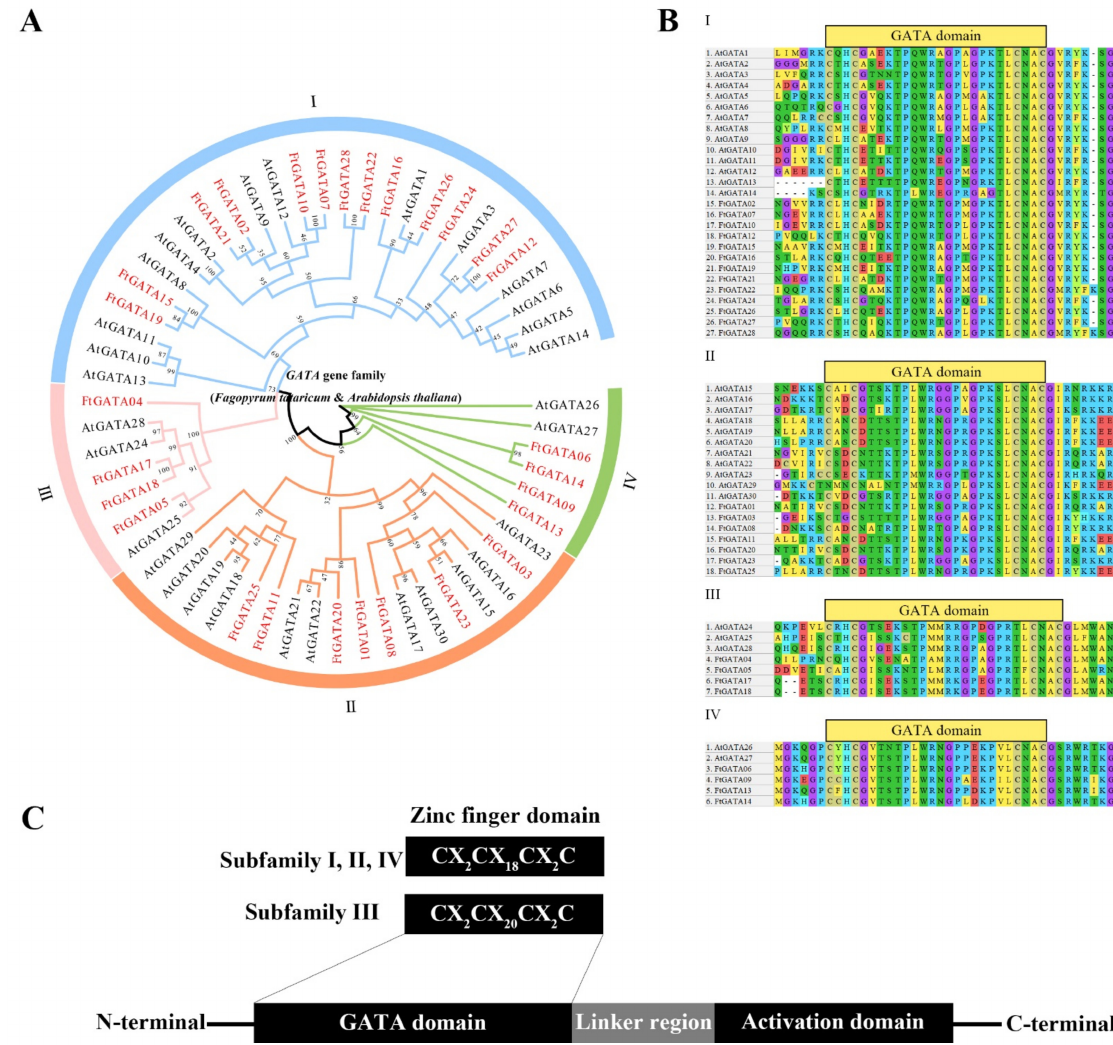
Figure 1. ( A ) Phylogenetic tree presenting the relationship between GATA domains of Fagopyrum tataricum and Arabidopsis thaliana . ( B ) Multiple sequence alignment of the four phylogenetic GATA domain subfamilies from F. tataricum and A. thaliana . ( C ) Zinc finger domain and activation domain of the FtGATA